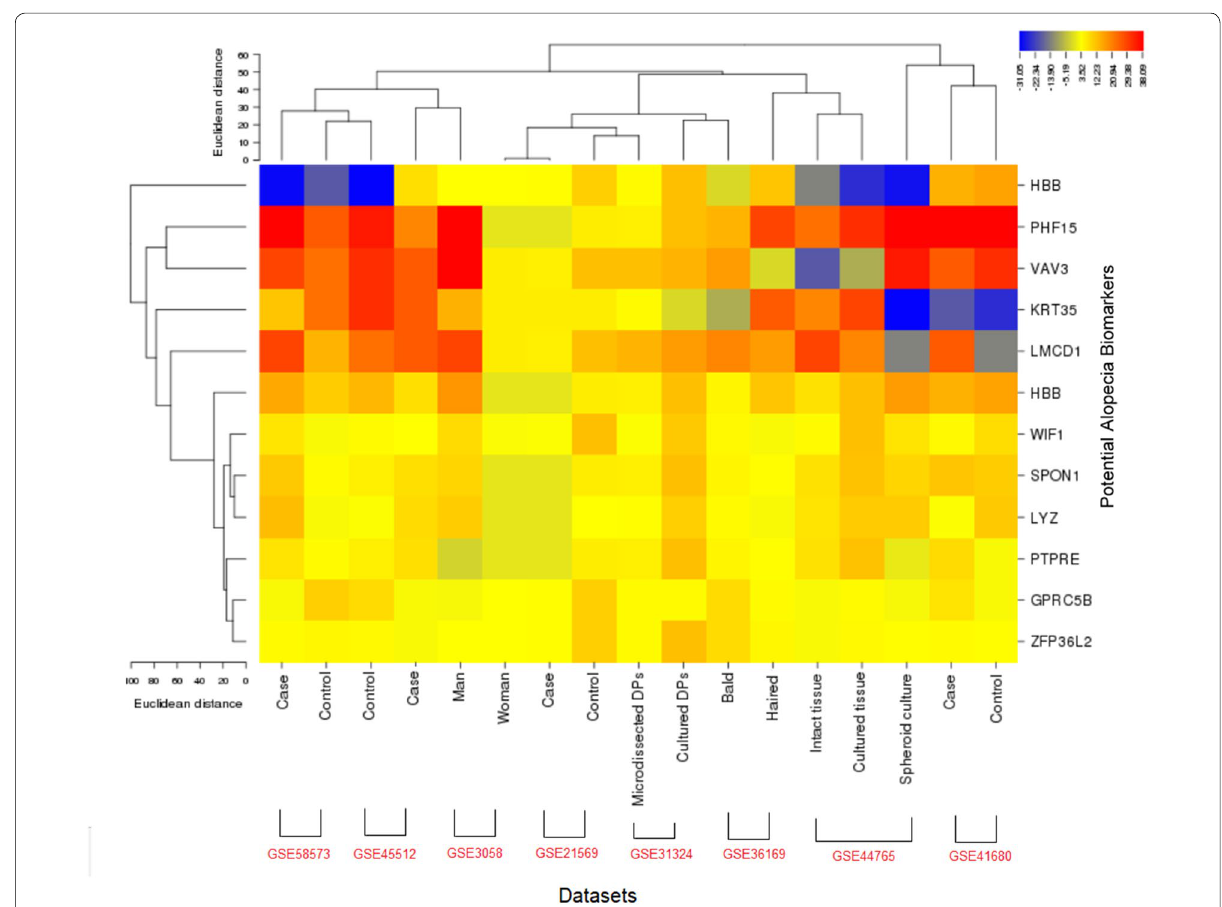
Fig. 4 Expression profiling (indicates expression level) of potential biomarker candidates in each sample of each dataset